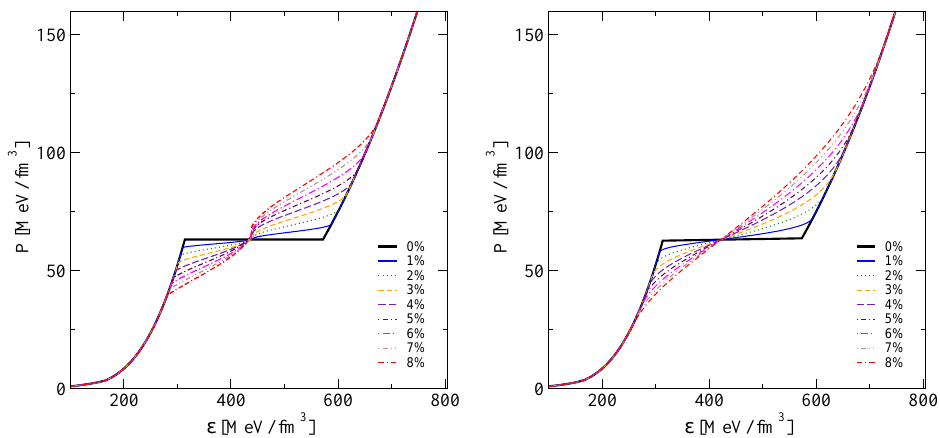
Figure 4. The EoS for pressure P vs. chemical potential µ for both MIM ( left panel ) and RIM for a sixth order polynomial ansatz ( right panel , k = 3) approaches to the mixed phase construction. Different curves labelled by percentages correspond to values of ∆ P = ∆ P / P c , where ∆ P = 0 corresponds to the Maxwell construction.